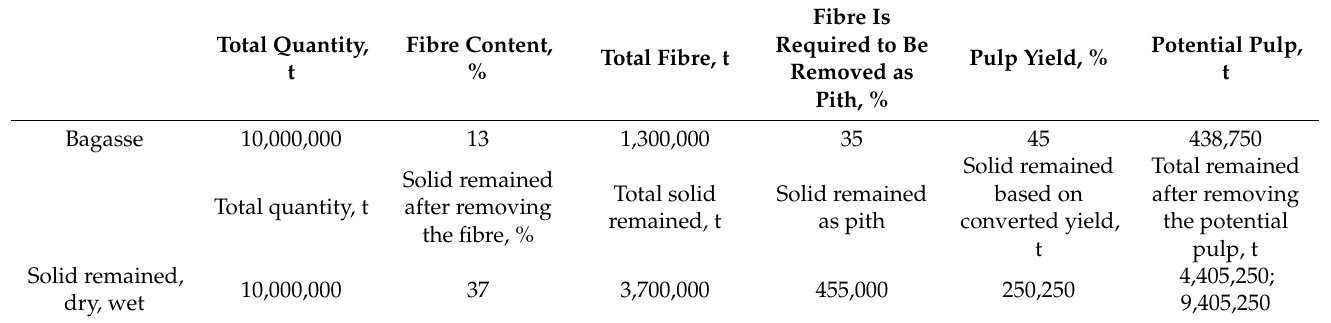
Table 33. Potential pulp production from Bagasse in Australia.